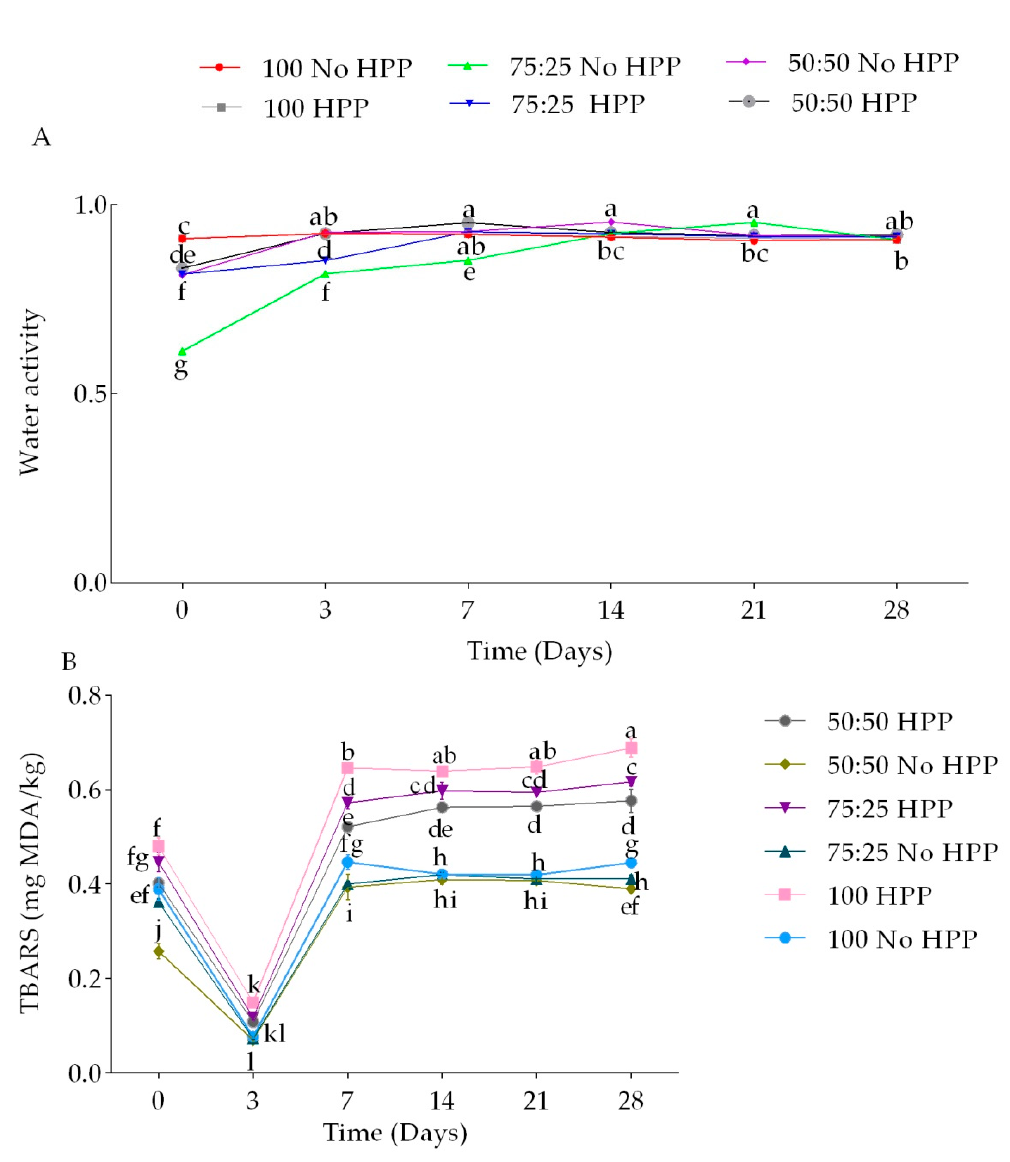
Figure 3. Effect of partial substitution of NaCl coupled with HPP on ( A ) water activity and ( B ) lipid oxidation of beef sausage under different cold storage days. Data were presented in means and SD. Different lower case letters indicate significant differences at p < 0.05 in Duncan’s multiple range tests using two-way